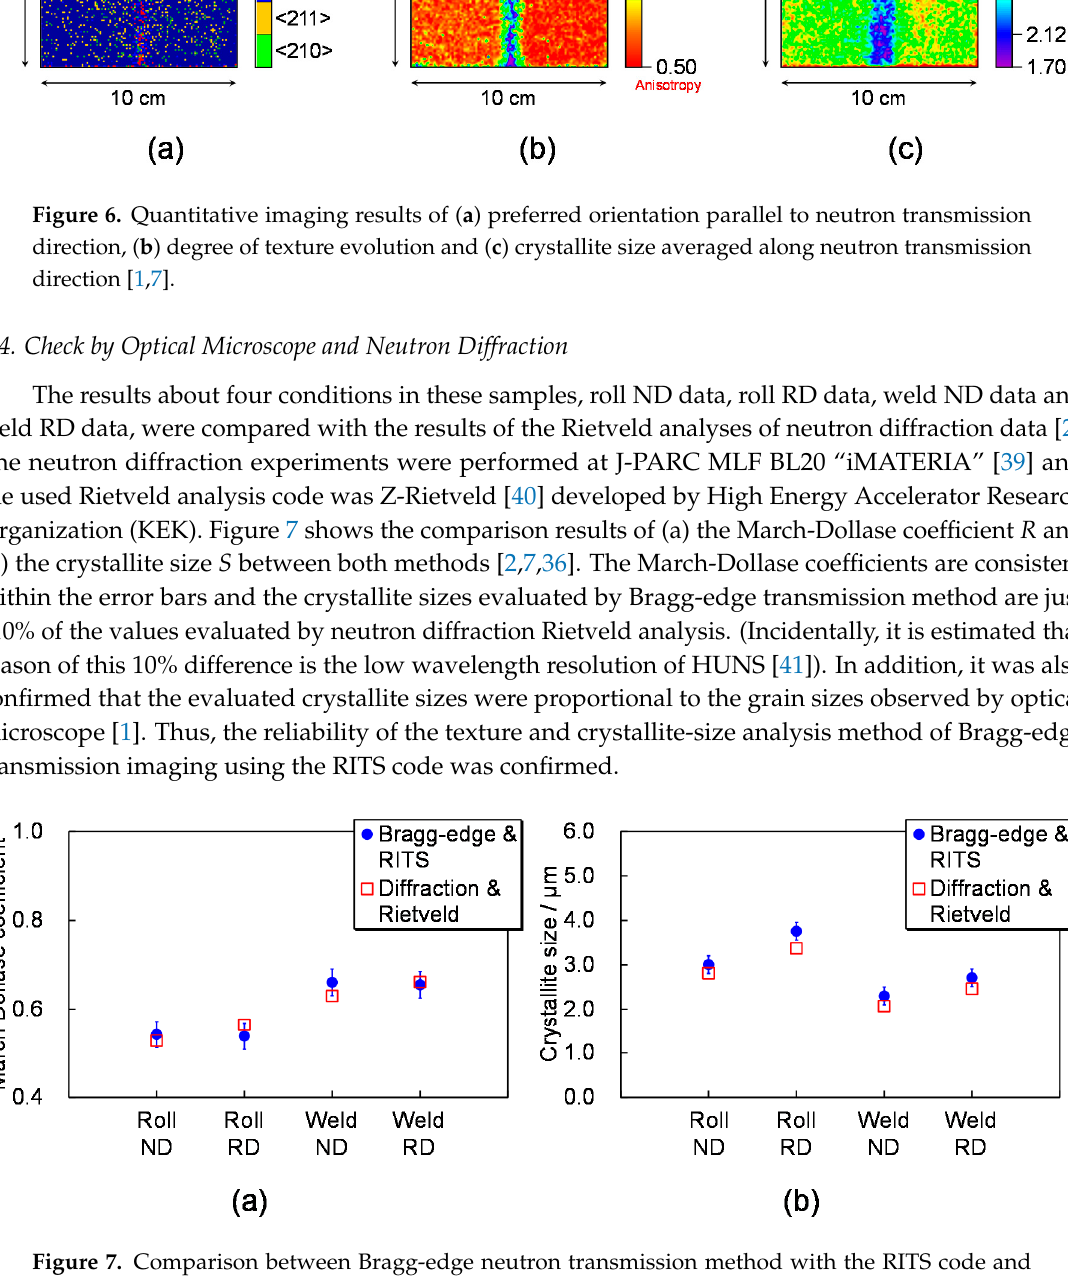
11 of 26 Figure 5. Three types of Bragg-edge transmission spectrum with the fitting curves [1]. Due to the texture effect and the extinction effect, spectrum shape and spectrum intensity are changed. From these profile changes, degree of crystallographic anisotropy, preferred orientation and crystallite size are quantitatively deduced. 3.3. Imaging Results The analyses using the RITS code were performed at each pixel of the imaging detector. Figure 6 shows quantitative imaging results of (a) preferred orientation < HKL > parallel to neutron transmission direction, (b) March-Dollase coefficient R indicating degree of crystallographic anisotropy and (c) crystallite size S [1]. According to Figure 6a, it is clearly visualized that the preferred orientation parallel to ND is <111> and the preferred orientation parallel to RD is <110>, respectively. These are consistent with the theory of rolling deformation textures [34]. According to